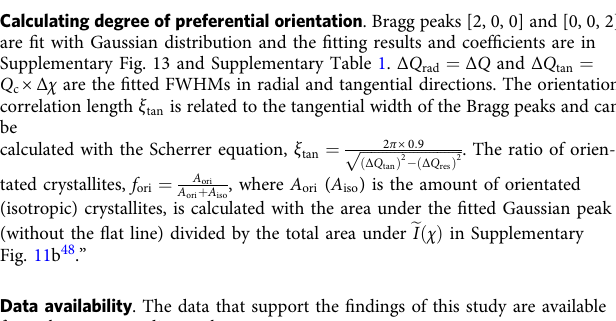
Supplementary Fig. 13 and Supplementary Table 1. Δ Q rad ¼ Δ Q and Δ Q tan ¼ Q c ´ Δ χ are the fi tted FWHMs in radial and tangential directions. The orientation correlation length ξ tan is related to the tangential width of the Bragg peaks and can be calculated with the Scherrer equation, ξ tan ¼